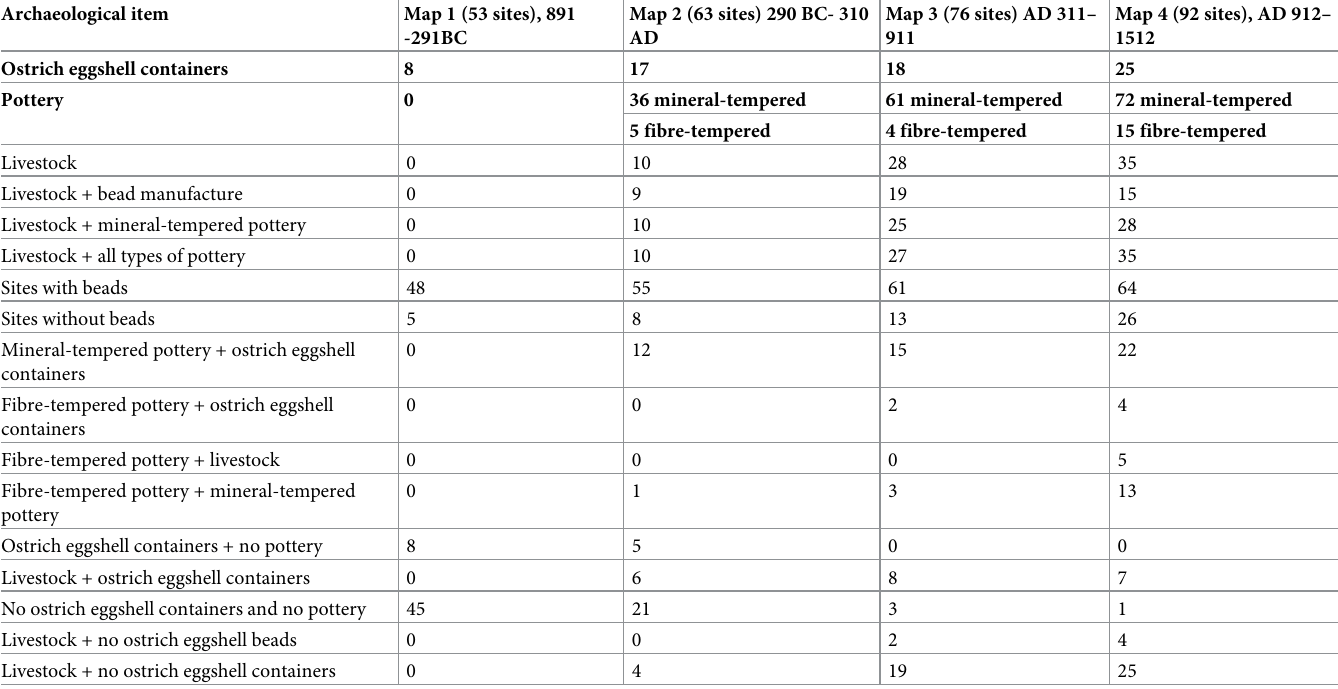
Table 1. Table showing the occurrence and co-occurrence of archaeological items during each of the four time